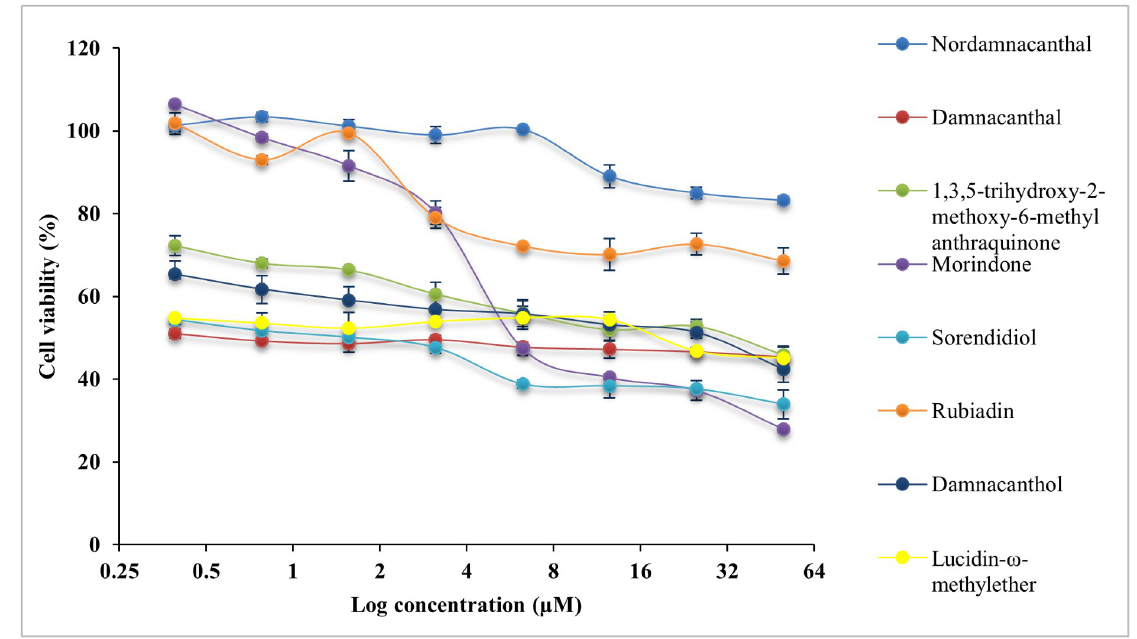
Fig 4. Cytotoxicity effect of anthraquinone compounds 1–8 on the cell viability of HCT116 cells. Data was shown as mean ± SD from three independent experiments.